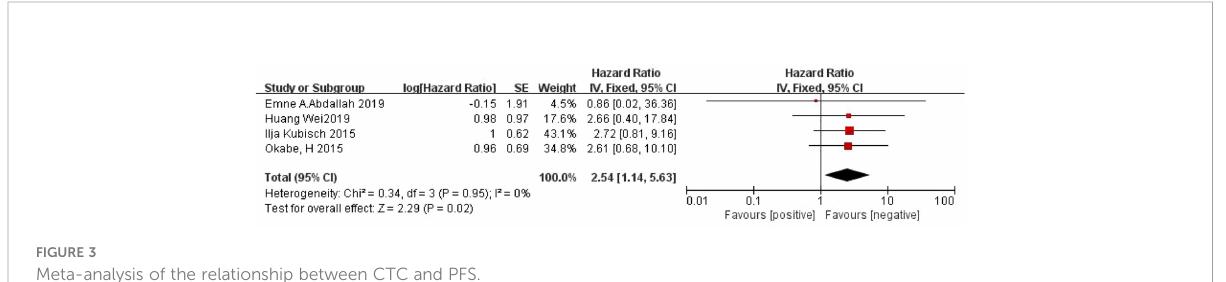
FIGURE 3 Meta-analysis of the relationship between CTC and